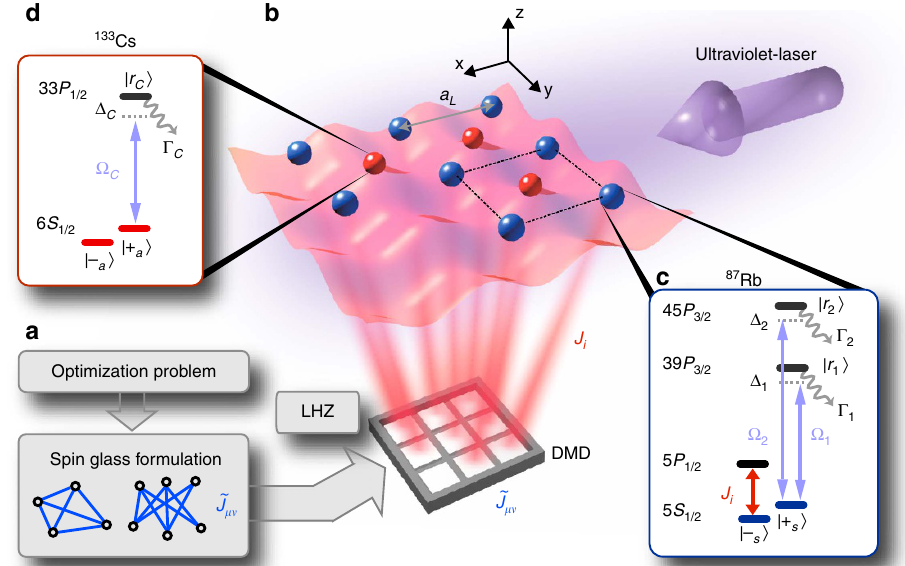
Figure 1 | Quantum Annealing with Rydberg atoms. ( a ) The cost function of a general optimization problem in the form of a spin glass with infinite-range interactions ~ J mn is encoded in the Lechner–Hauke–Zoller (LHZ) architecture in local fields J i . ( b ) Rubidium (blue) and Caesium (red) atoms are trapped in a square lattice geometry representing physical and ancilla spins, respectively, where the spin degree of freedom is encoded in two long-lived hyperfine states þj i and (cid:2)j i , illustrated in insets ( c , d ). The programmable local fields J i are induced by AC stark shifts from laser coupling the (cid:2) s j low-lying 5 P states using a digital mirror device (DMD). The four-body gauge constraints at each plaquette (for example, the black dotted square) are engineered using off-resonant laser coupling of the þ s j i ; þ a j i states to Rydberg P -states j r 1 i , j r 2 i or j r C i and require only uniform illumination of the system with ultraviolet laser light. G 1 , G 2 and G C are the decay rates from the excited